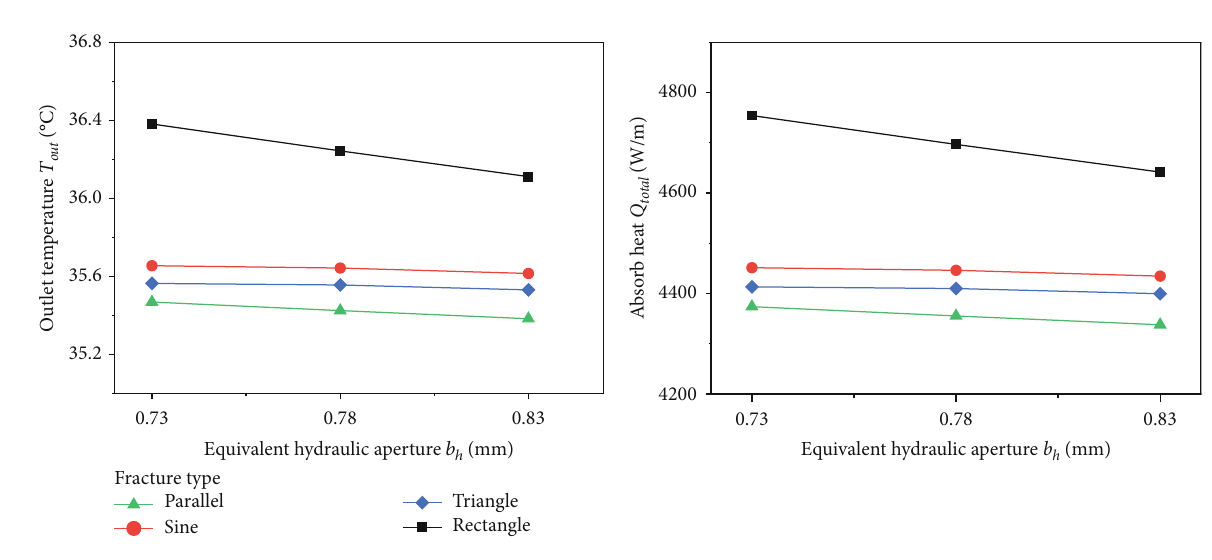
Figure 12: Fracture morphology and heat transfer e ffi ciency.